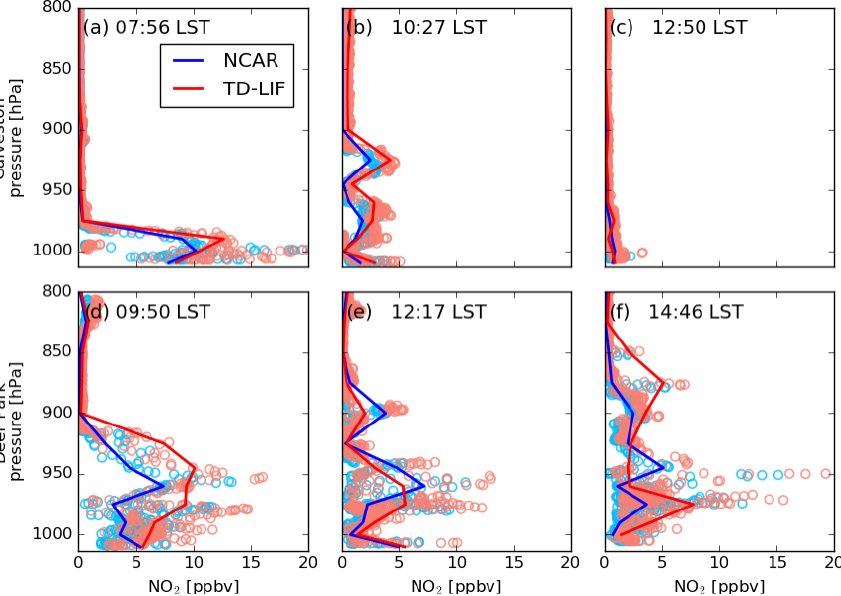
Figure 7. Vertical distribution of NO 2 mixing ratios at different local solar time (LST) over Galveston (a, b, c) and Deer Park (d, e, f) in TX measured by the NCAR (light blue) and TD-LIF (orange) instruments. The circles in lighter colors represent 1s measurements, and the solid lines show the mean values for NCAR (blue) and TD-LIF